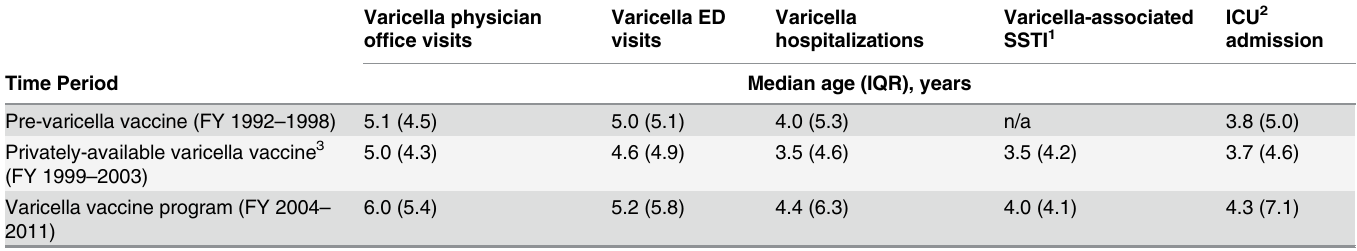
Table 2. Median (IQR) age of varicella cases by clinical setting in the pre-varicella vaccine period, the privately-available varicella vaccine period and varicella vaccine program